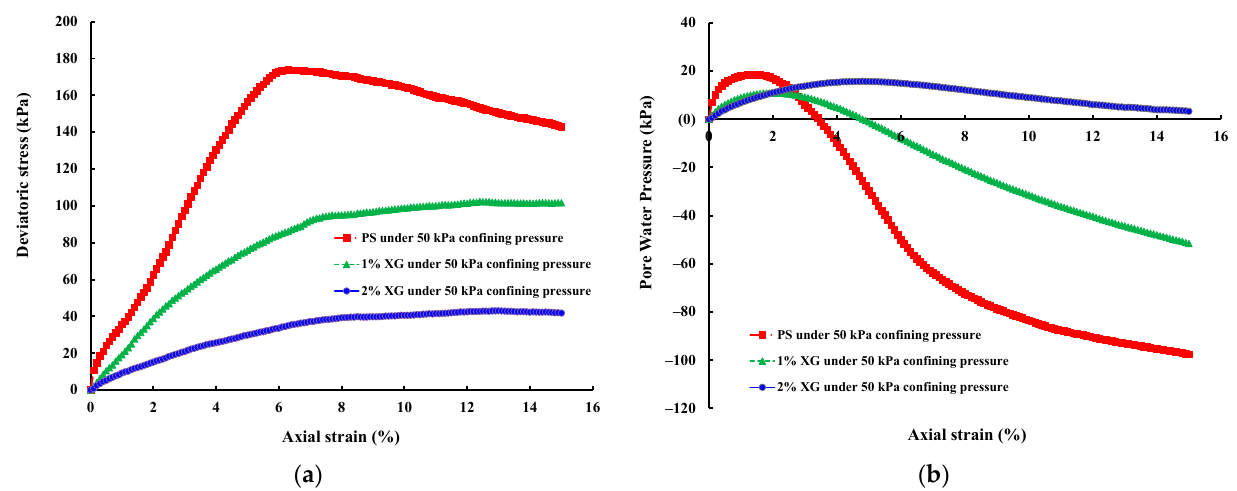
Figure 5. Results of CU triaxial tests, ( a ) deviatoric stress-axial strain curves; ( b ) pore water pressures. The soil shear parameters for the untreated and XG-treated soil were obtained through the plotted failure envelope curves (Figure 6).